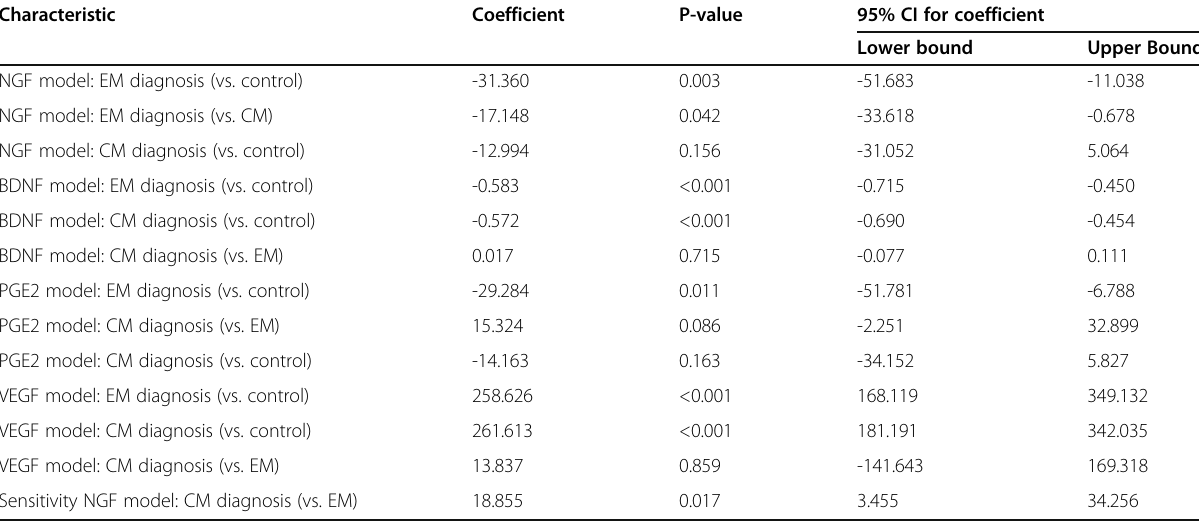
Table 3 Parameter estimates in multivariable analysis of factors associated with peripheral levels of NGF, BDNF, PGE2, and VEGF Characteristic Coefficient P-value 95% CI for coefficient